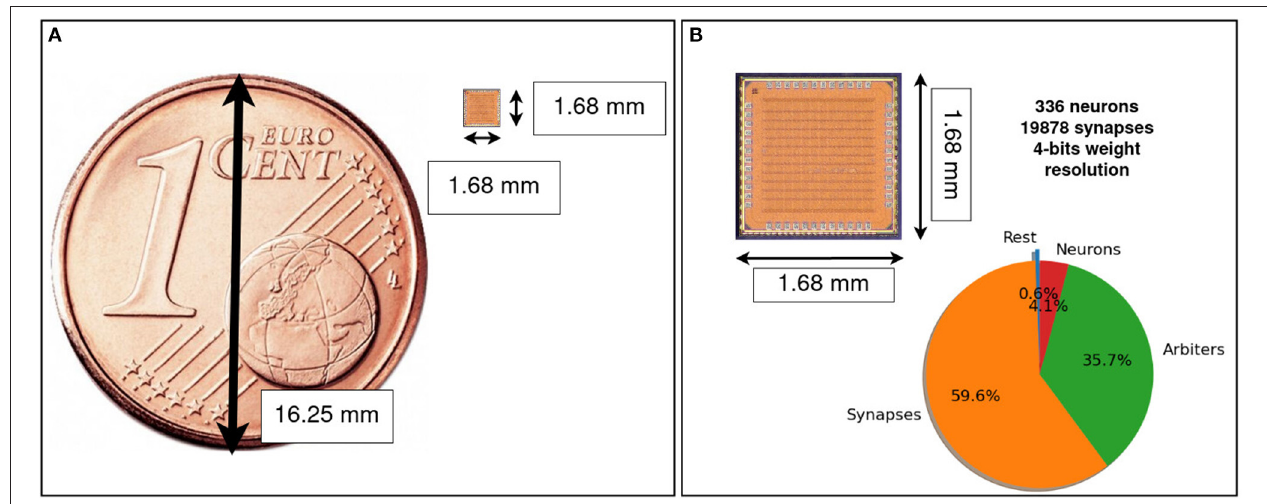
FIGURE 5 | µ Brain’s micro-graph, the IC is implemented in 40 nm TSMC technology with an I/O voltage of 2.5 V and a core voltage of 1.1 V. (A) Micro-graph picture compared with a Euro cent coin. IC area is 2.82 mm 2 (including pads). (B) Area breakdown: 59.6% flip-flops for synaptic weights and tri-state weight selectors (synapses), 35.7% spike arbiters, 4.1% neuron accumulators, and 0.6% remaining routing logic. Memory is completely distributed over the area (no Von-Neumann